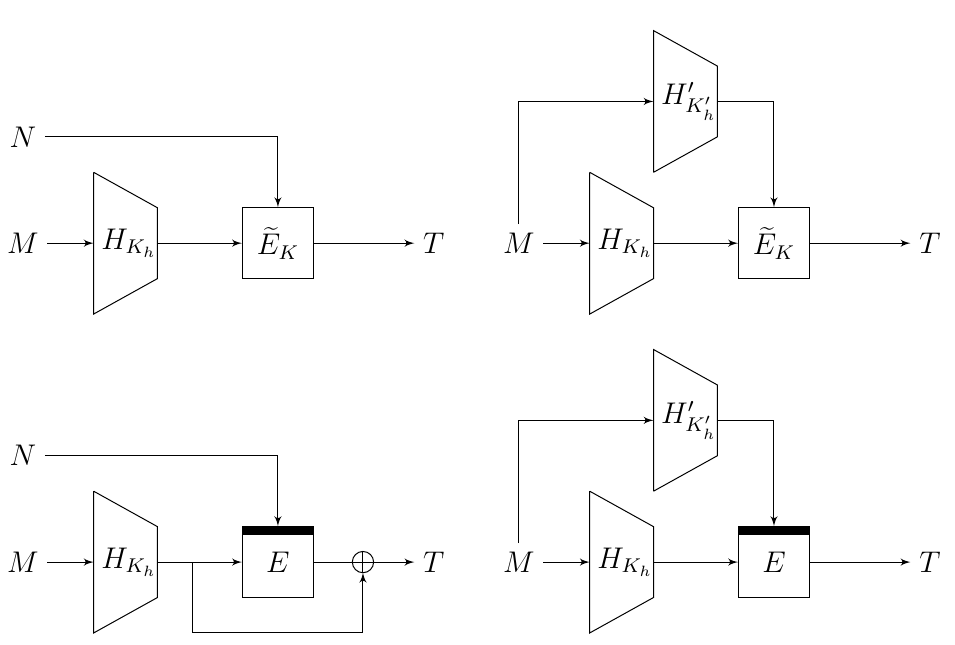
Figure 1: Top: the TBC-based constructions NaT (left) and HaT (right) based on a TBC e E and AU hash functions H and H 0 . The tweak input is on top of the e E K box, while the block input is on the left. Bottom: the block cipher-based variants NaK (left) and HaK (right) based on a block cipher E and AU and almost uniform hash functions H and H 0 . The solid line materializes the key input for E